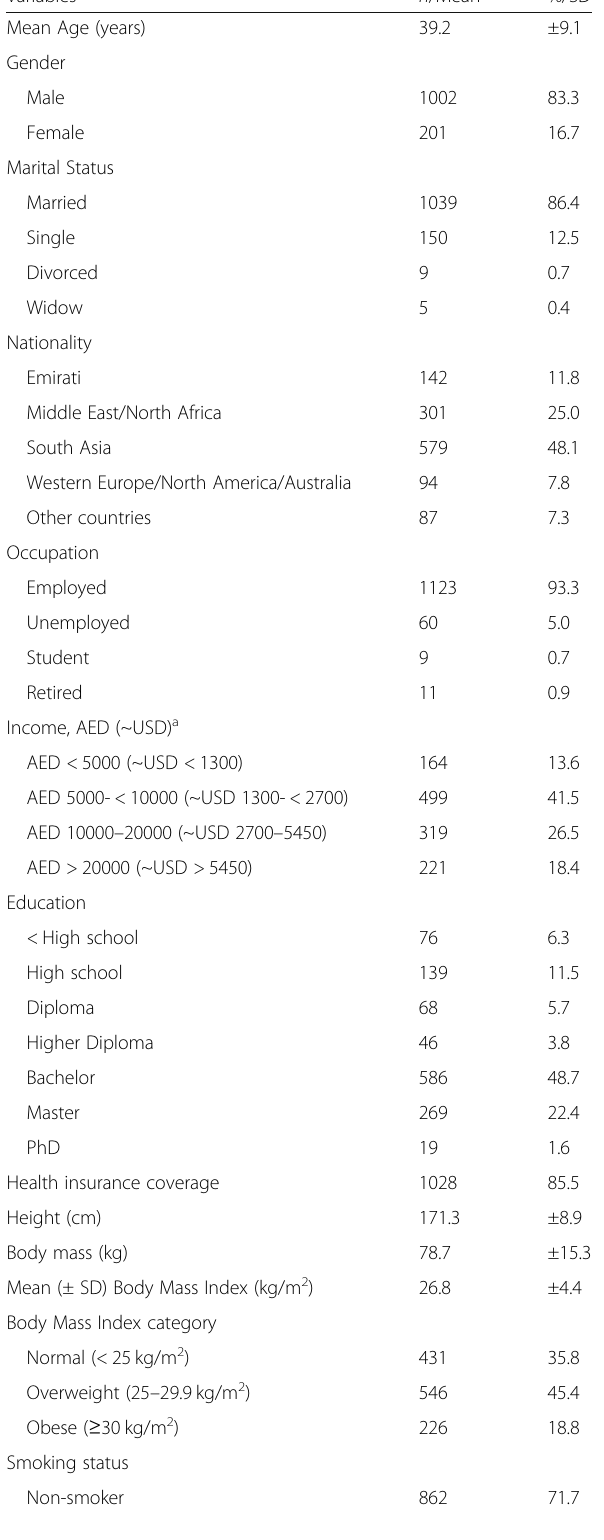
Table 1 Characteristics of participants, cross-sectional study of HS use and HS-related adverse events, Dubai, 2015 ( n = 1203)